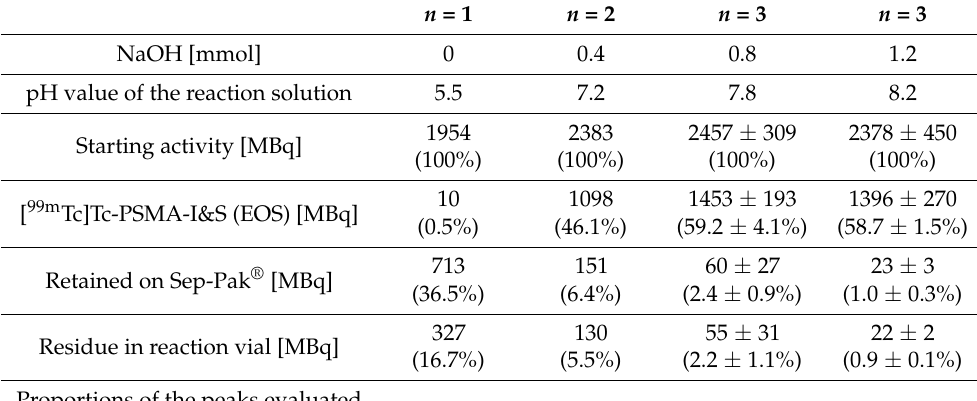
Figure 3. Representative radio–HPLC chromatogram of a [ 99m Tc]Tc-PSMA-I&S product solution. In the radio-trace, the principal peak at 8.59 min (93.2%) and the impurity at 9.48 min (5.5%) are visible. At the UV-trace, the peak at 9.32 min was assigned to cold PSMA I&S. The peak at 10.45 min was assigned to the formed dimer. Table 1. Reaction conditions and radiochemical purity evaluation of [ 99m